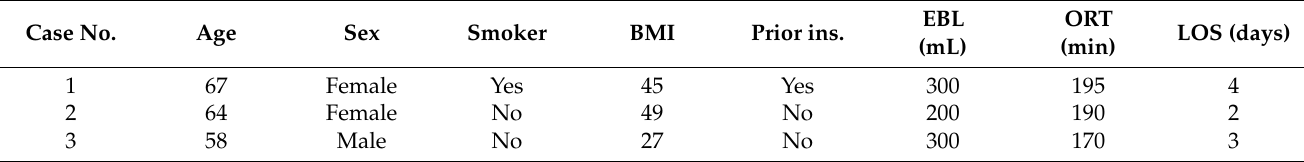
Table 1. ACR cases demographic, clinical, and perioperative data.